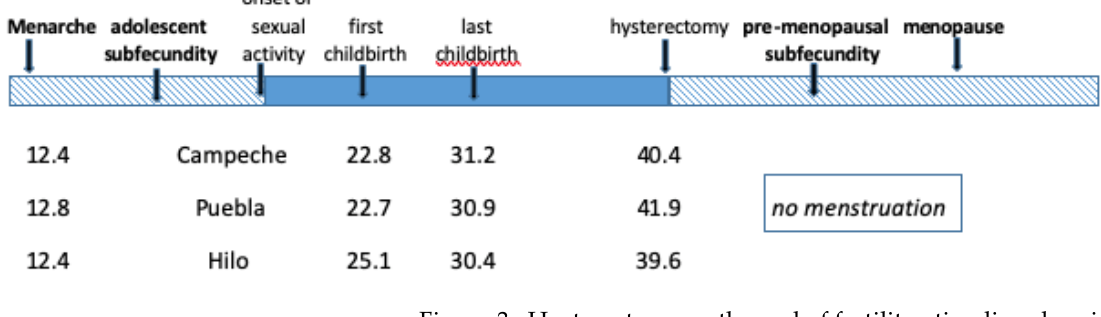
Figure 3: Hysterectomy as the end of fertility: timeline showing mean recalled ages (in years) at menarche, first childbirth, last childbirth, and hysterectomy in Campeche, Puebla, and Hilo. Dark blue indicates fertile